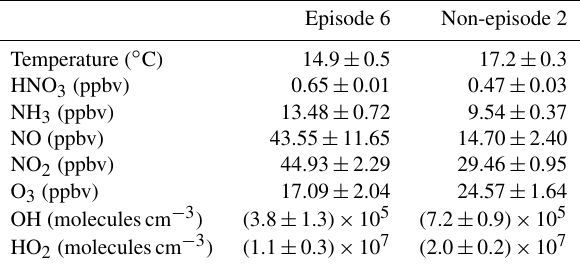
Table 5. Comparison of temperature, HNO 3(g) , NH 3(g) , NO, NO 2 , O 3 , and simulated OH and HO 2 between episode 6 and non- episode